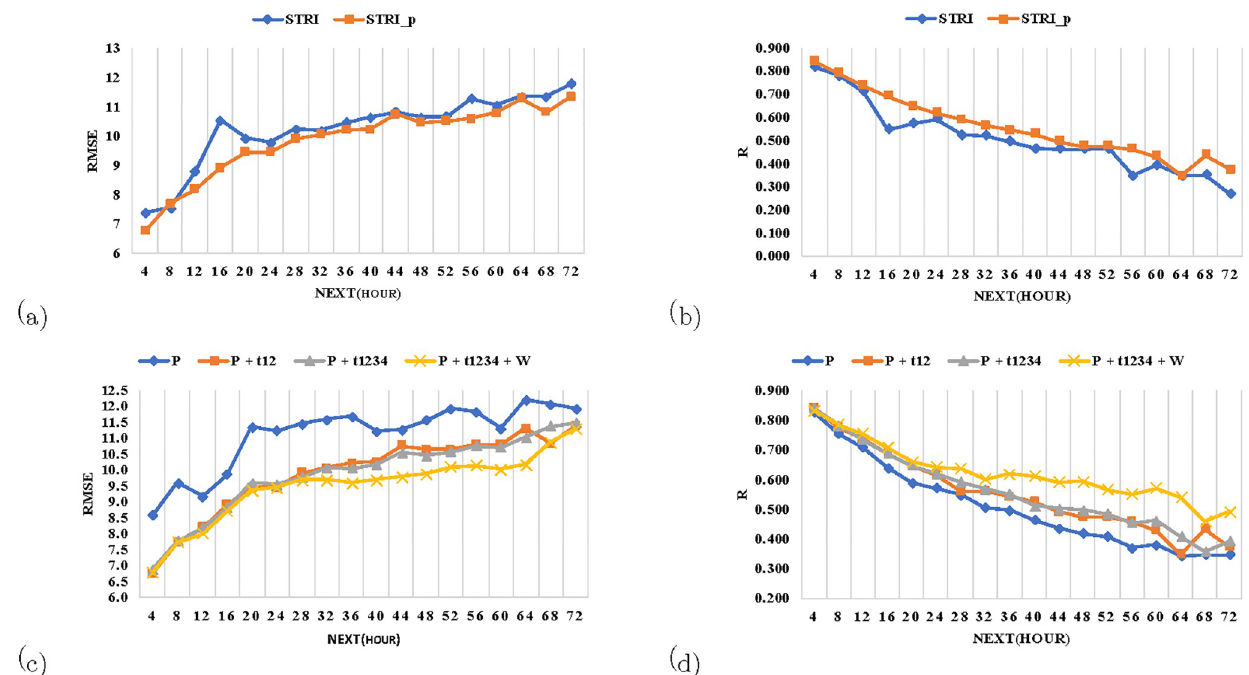
Fig 7. STRI, STRI_p and RTP performance. Top:Performance of STRI and STRI_p components from +4h to +72h in (a)RMSE and (b)R. Down:Results in (c)RMSE and (d)R given remote pollutant and local features using STRI_p component.